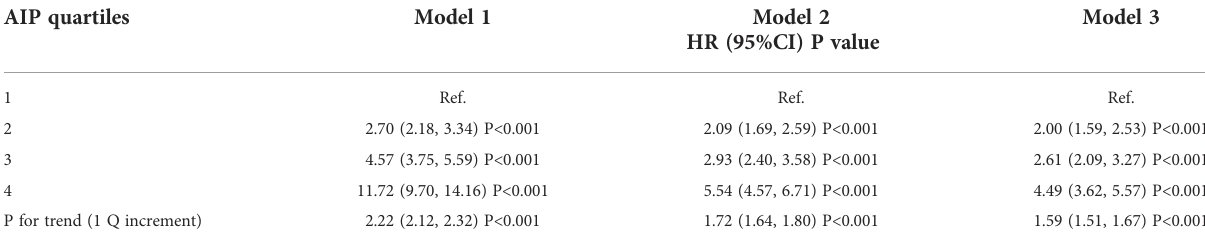
TABLE 2 Association between AIP and new-onset NAFLD in different